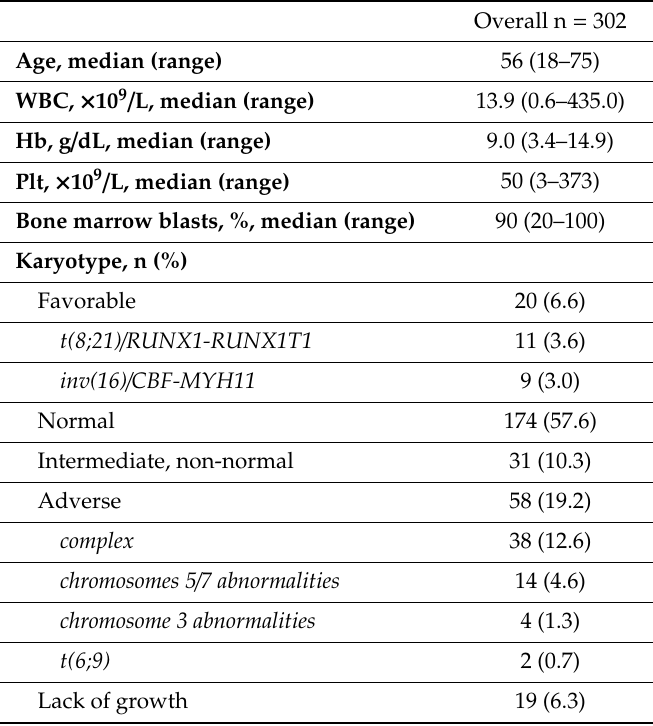
Table 1. Characteristics of patients in the overall